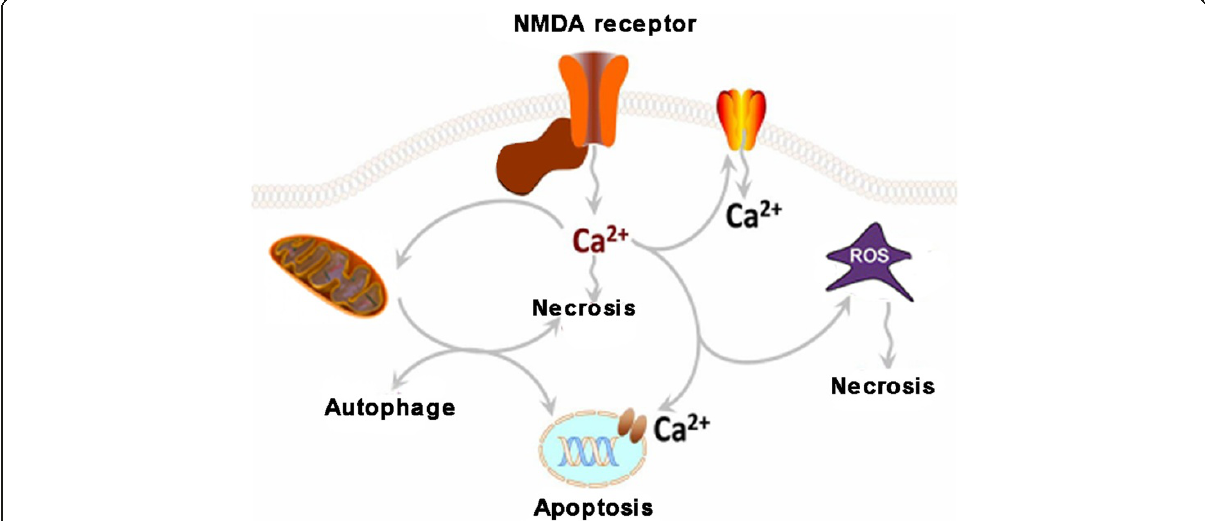
Figure 1 Excitatory neurotransmitter (glutamate) acts at extrasynapses and over-activates NMDA receptors in stroke. Over-activation of NMDA receptor leads to excessive Ca 2+ loading into cells. Overloading of Ca 2+ induce mitochondria injury, thus causes necrosis and generation of ROS/RNS. On the other hand, excessive intracellular Ca 2+ also activate Ca 2+ channels on nuclear membrane, causing DNA damage and cell apoptosis. DNA damage also promotes the expression of apoptosis and autophagy related genes, and finally induce cell apoptosis and